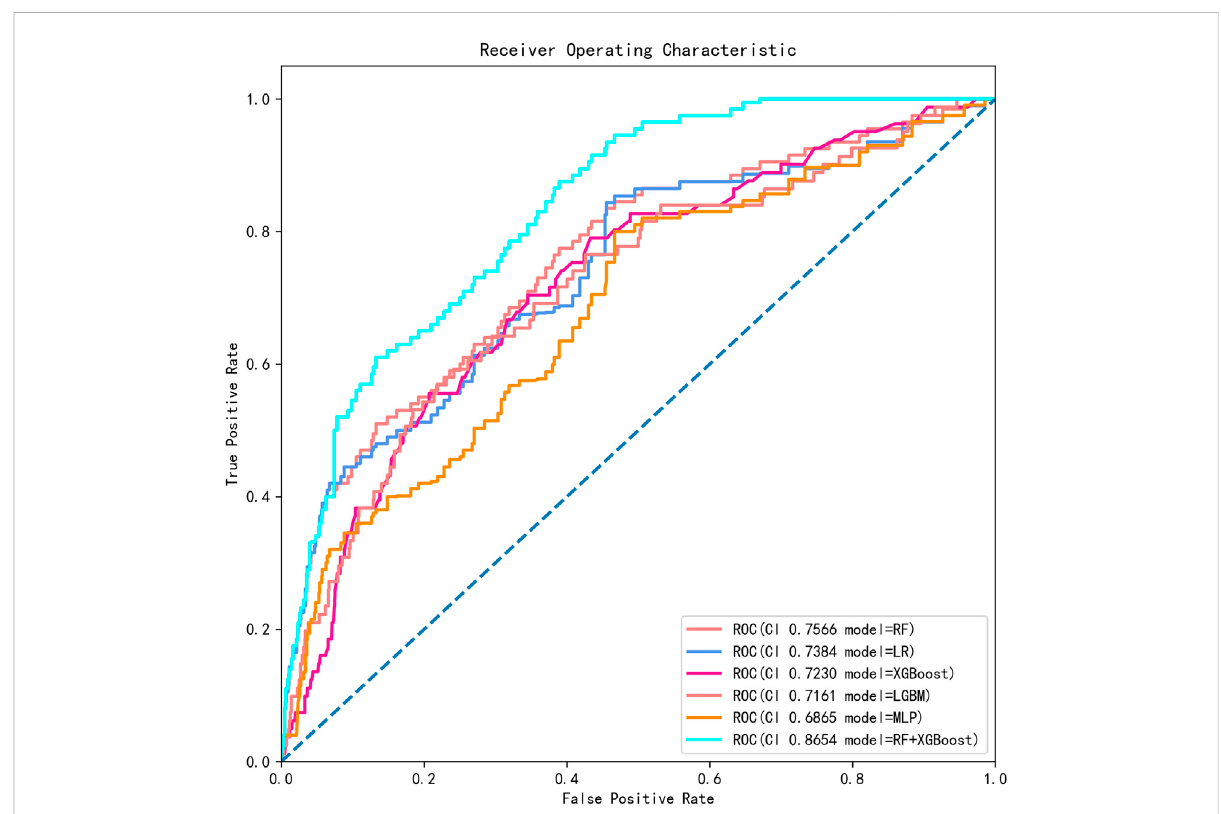
FIGURE 3 The ROC curves and AUCs of six ML algorithms predicting postoperative unplanned 30-day hospital readmission in this cohort. ROC, receiver operating characteristic; AUC, area under the curve; RF, random forest; LR, logistic regression; XGBoost, eXtreme Gradient Boosting; LGBM, Light Gradient Boosting Machine; MLP, Multilayer